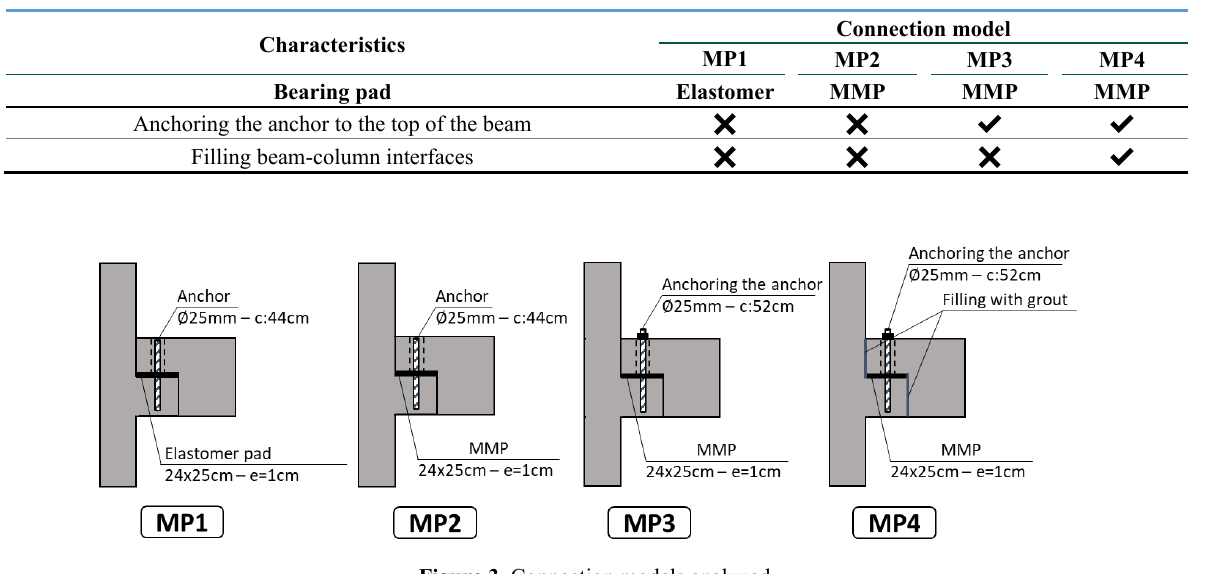
Figure 3. Connection models